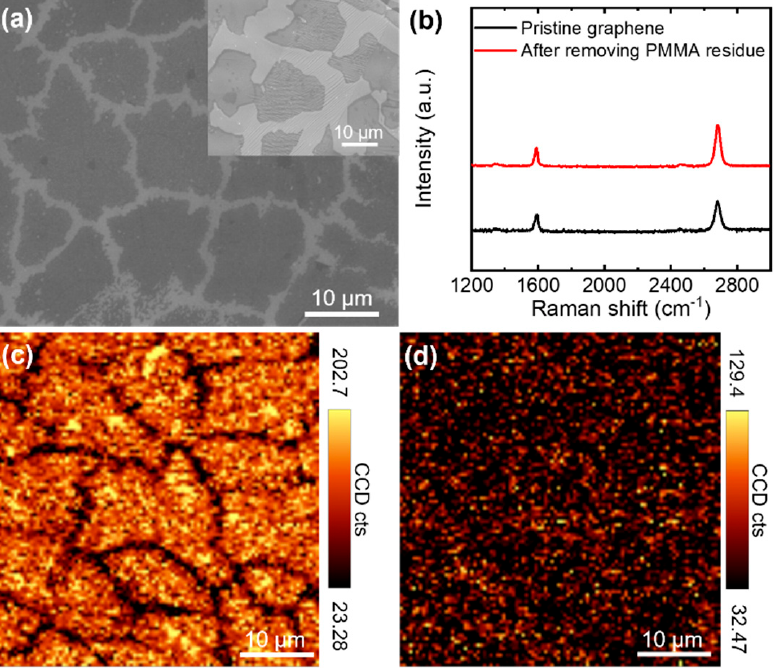
Figure 2. ( a ) SEM image of CVD-grown monolayer graphene flakes transferred onto SiO 2 . The inset shows the SEM image of monolayer graphene grown on the surface of copper foil. ( b ) Raman spectra of CVD-grown monolayer graphene placed on SiO 2 before and after the removal of the polymer residue. ( c , d ) Raman maps for the integrated intensity of ( c ) the G (1542–1642 cm − 1 ) and ( d ) D bands (1314–1414 cm − 1